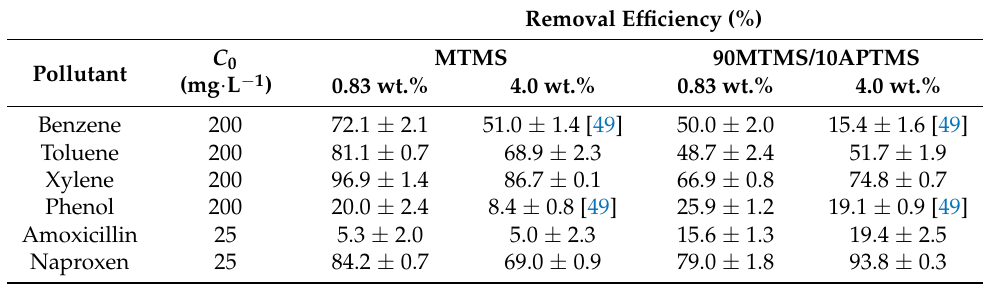
Table 1. Silica precursor system, amounts of CTAB used during the synthesis and the removal efficiency of the materials for the studied